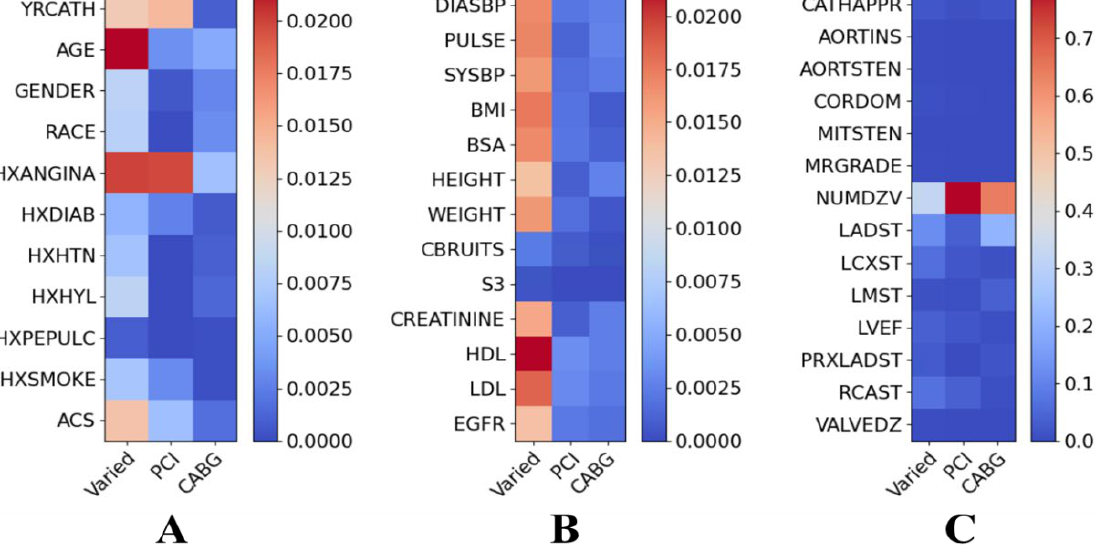
Figure 2. Heatmaps of different feature groups. ( A ) The combination of demographics information and patient medical history features heatmap; ( B ) included all patient examination results (physical examination, vital signals, laboratory results); and ( C ) the heatmap of all the CR features.